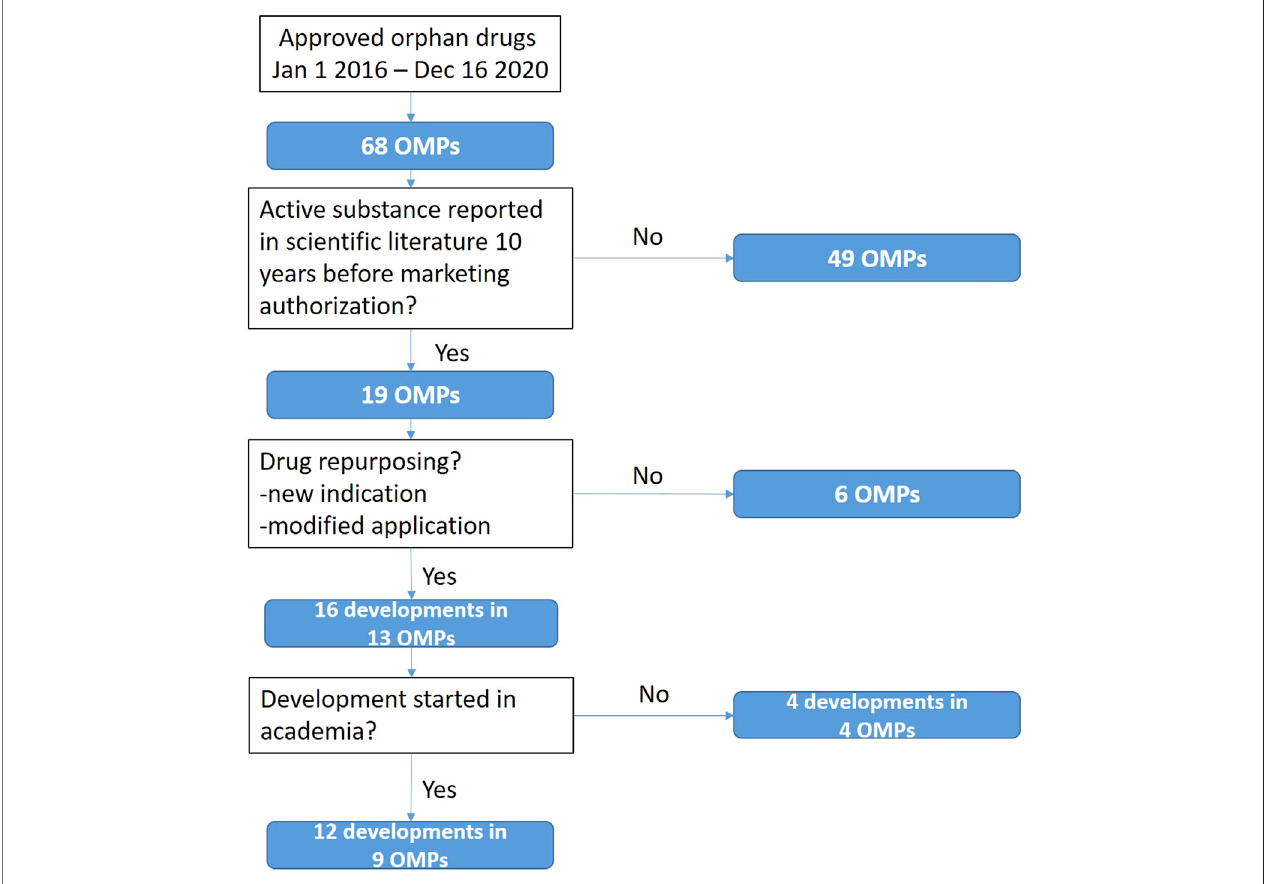
FIGURE 1 | Outline of the process to identify repurposed orphan medicinal products approved by the European Medicines Agency.